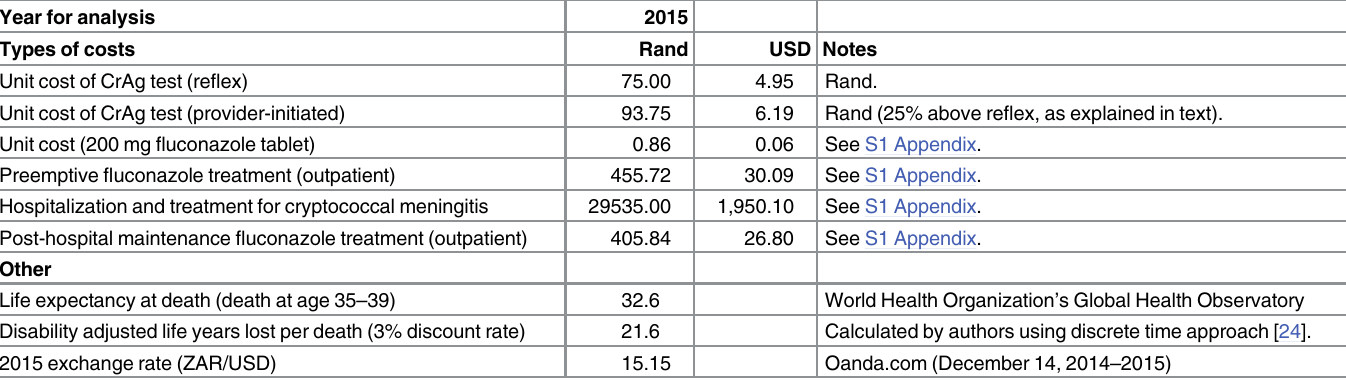
Table 2. Basic unit costs and model